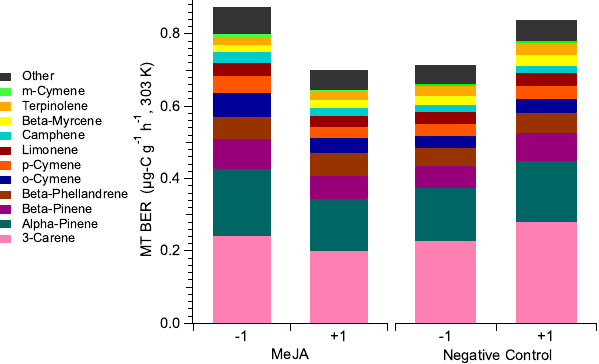
Figure 11. Results from two Pinus aristata experiments. Shown above is the time series of the sum monoterpenoid basal emission rates normalized to 303K as a function of elapsed time since treat- ment application for the methyl jasmonate (MeJA) experiment (PA- E) and the negative control experiment (PA-C).